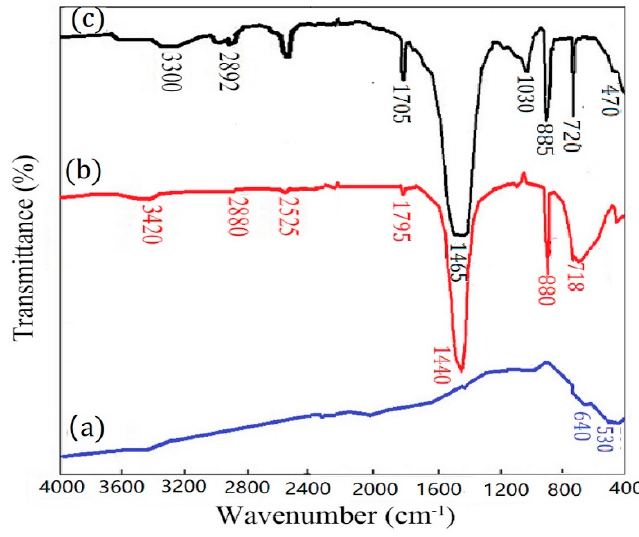
Figure 3. Fourier-transform infrared spectra (FT-IR) spectra of ( a ) CaCO 3 , ( b ) TiO 2 , and ( c ) CaCO 3 -TiO 2 composite particles.